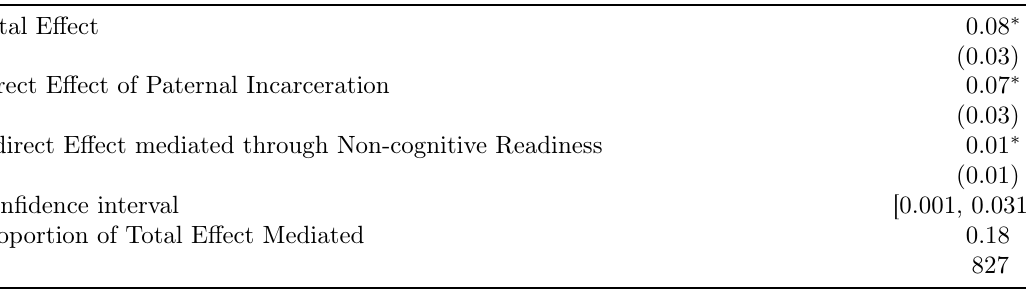
Table 3: Results from Non-cognitive School Readiness Mediation Models for Special Education Place- ment at Year